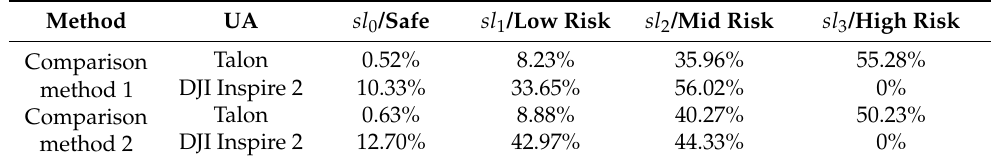
Table 8. The proportion of areas in different safety